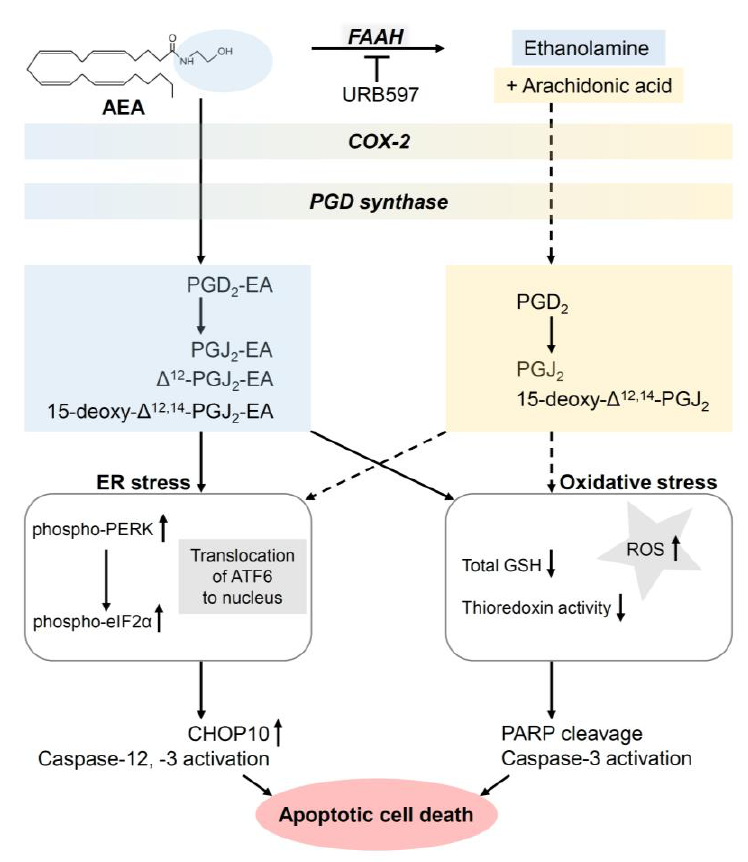
Figure 3. Proapoptotic effect of AEA and its metabolites formed via COX-2 and PGD synthase on tumorigenic keratinocytes. The arrows indicate the sequential activations and inductions triggered by the indicated substances. In the case where URB597 is listed with an inhibitory arrow directed at FAAH, URB597 resulted in an enhancement of the AEA effect shown. The dashed arrows indicate possible additional effects of AEA after degradation to arachidonic acid. All abbreviations are given in the text.